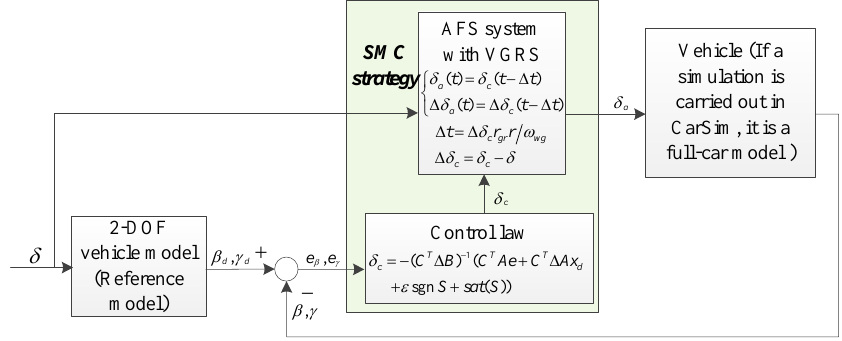
Figure 8. Control block diagram of the proposed system.